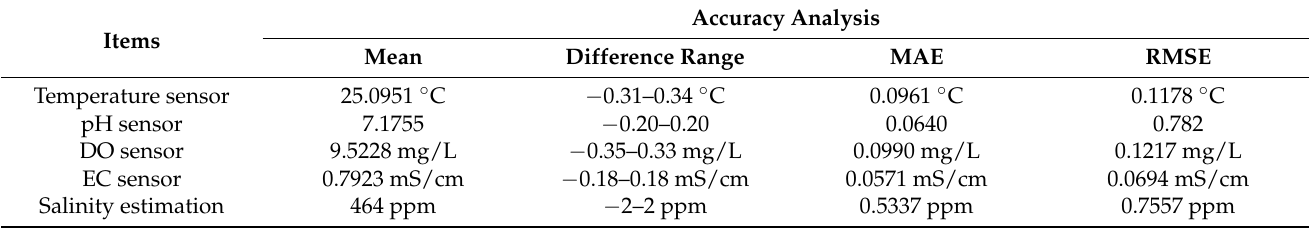
Table 6. Accuracy analysis of water temperature, pH, DO, and EC, and salinity levels for in situ measurement.